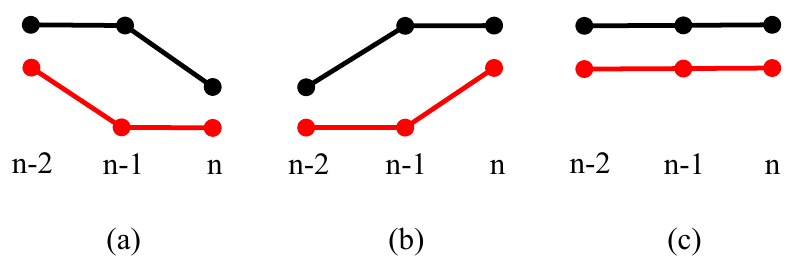
Figure 8 . T ( n − 1) ≠ 00. ( a ) A vehicle has just left the measuring range; ( b ) A vehicle